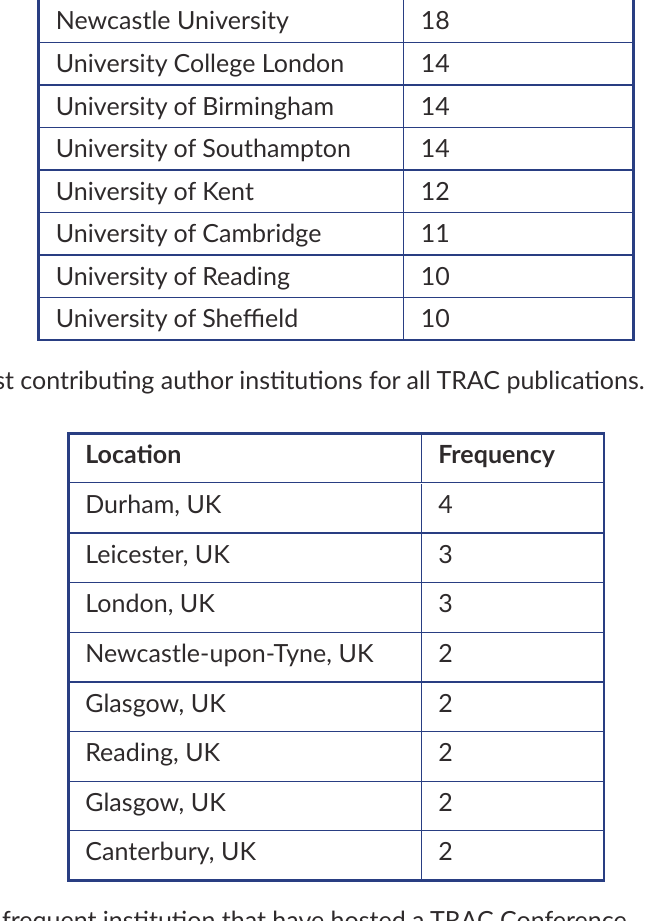
Table 4: Ten most frequent institution that have hosted a TRAC